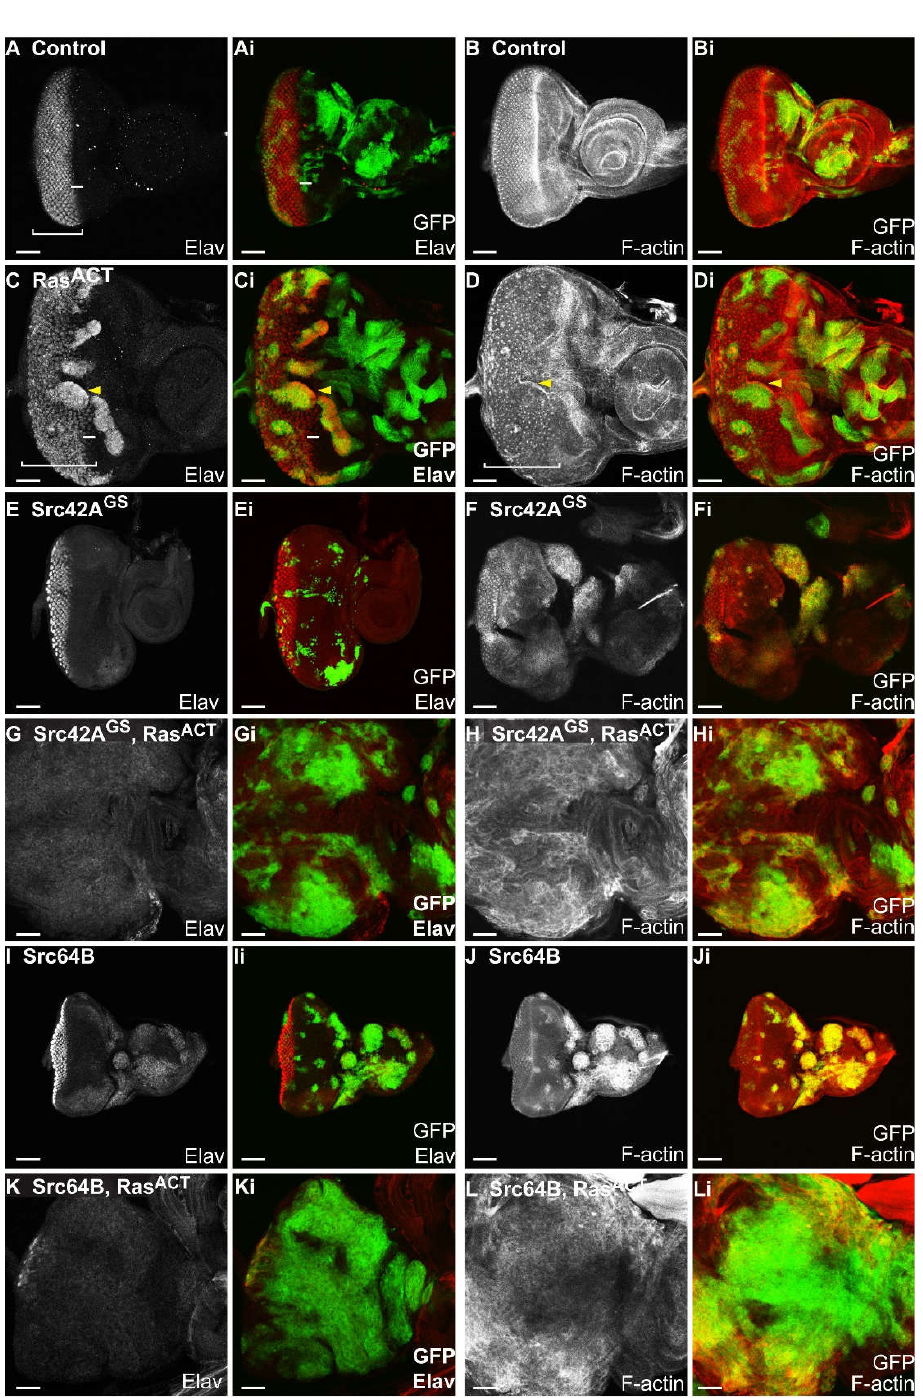
Figure 2. Src and Ras ACT cooperate in clonal analysis of eye disc clones. Confocal images, planar views, of third instar eye‐antennal imaginal discs with posterior to the left, in this and subsequent eye antennal imaginal disc figures. GFP (Green Fluorescent Protein) marked clones (green in merged images) were generated using ey-FLP MARCM in this and subsequent figures. Elav marks differentiated cells (red in merged images) and rhodamine‐phalloidin visualises F‐actin to mark cell outlines (red in merged images). Scale bar, 50 μM. The small bars in A,C indicate the morphogenetic furrow, and the brackets in A , C , D indicate the differentiated region of the eye disc. Genotypes: ( A , B ) Control: ey-FLP1 , UAS-mCD8-GFP/+ ; +/+; tub-GAL4 FRT82B tub-GAL80/FRT82B ; ( C , D ) Ras ACT : ey- FLP1 , UAS-mCD8-GFP/+ ; UAS-Ras ACT /+; tub-GAL4 FRT82B tub-GAL80/FRT82B ; ( E , F ) Src42A GS : ey- FLP1 , UAS-mCD8-GFP/+ ; GS11049/+ ; tub-GAL4 FRT82B tub-GAL80/FRT82B ; ( G , H ) Src42A GS , Ras ACT : ey-FLP1 , UAS-mCD8-GFP/+ ; GS11049 , UAS-Ras ACT /+; tub-GAL4 FRT82B tub-GAL80/FRT82B ; ( I , J ) Src64B: ey-FLP1 , UAS-mCD8-GFP/+ ; UAS-Src64B/+ ; tub-GAL4 FRT82B tub-GAL80/FRT82B ; and ( K , L )